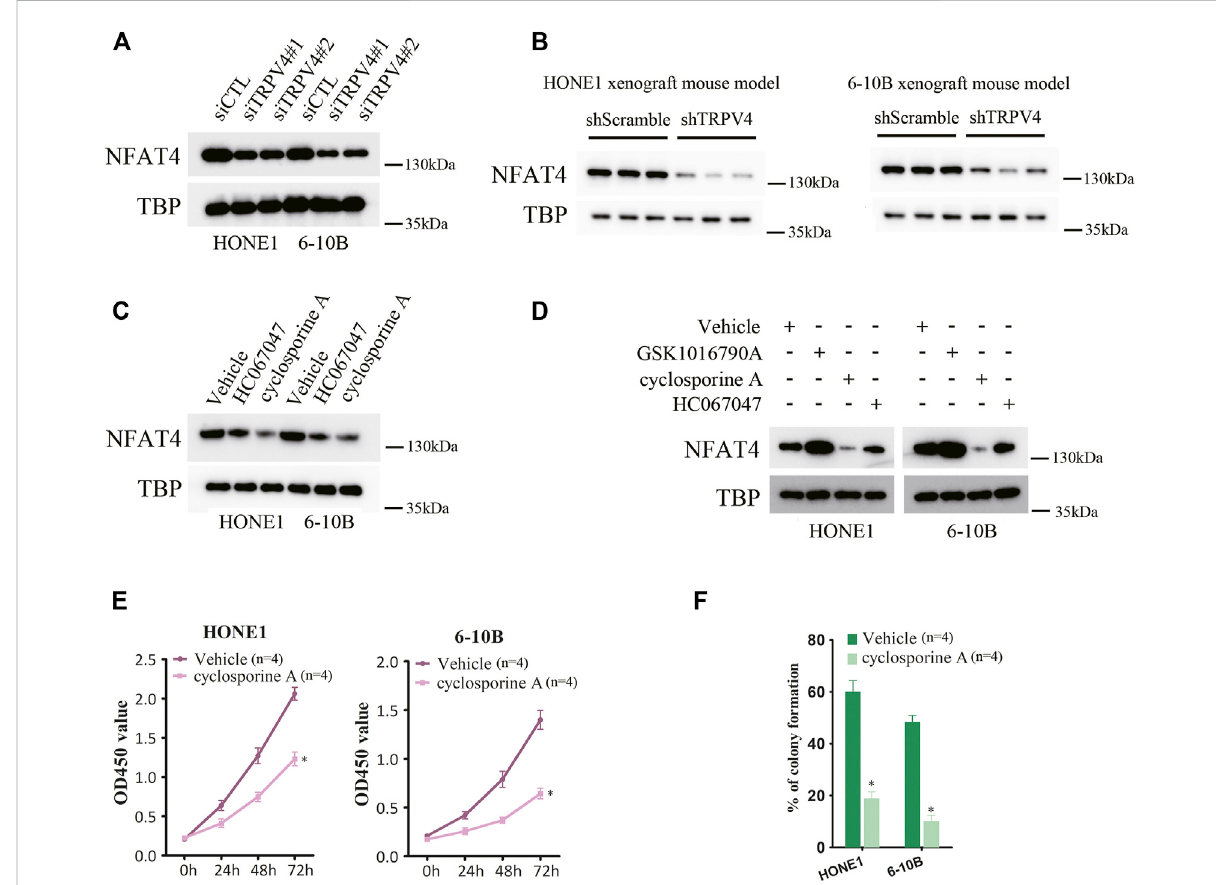
FIGURE 5 Inhibition of TRPV4/calcineurin suppresses NFAT4 activation (A) Immunoblot showing NFAT4 protein expression in the nuclear fraction of TRPV4-knockdown NPC cells (n = 3). (B) Immunoblot showing NFAT4 expression in the nuclear fraction of control or TRPV4-knockdown tumor cells from xenografts (n = 3). (C) Immunoblot showing NFAT4 expression in the nuclear fraction of NPC cells pretreated with HC067047 or cyclosporine A (n = 3). (D) Immunoblot showing NFAT4 expression in the nuclear fraction of NPC cells pretreated with HC067047 or cyclosporine A before exposure to GSK1016790A (n = 3). (E,F) The effect of cyclosporine A on (E) cell proliferation and (F) colony formation (n = 4). The data represent the mean ± SEM. * p < 0.05, versus shScramble. siCTL or